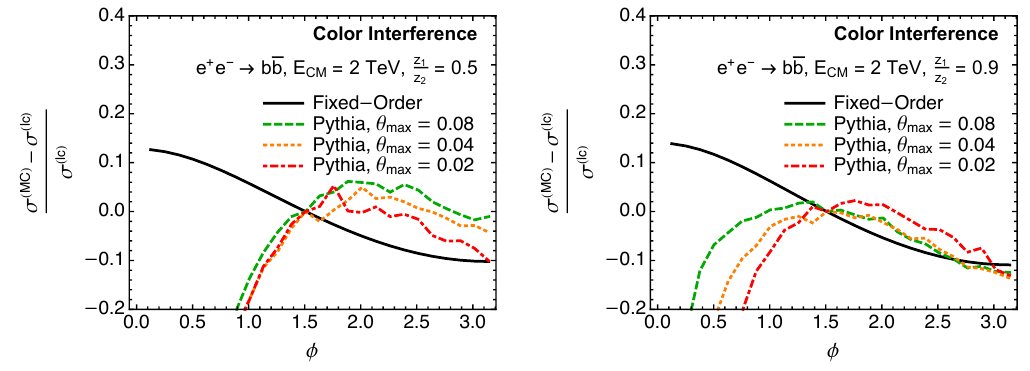
Figure 5: Azimuthal angle distribution in the simulated e + e − → b ¯ b events, scanning over the maximal angle of emissions from the bottom quark, θ / z = 0.5. Right: ratio of emission angles z emission angles z 1 2